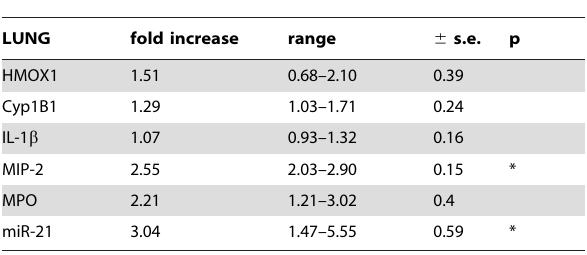
Table 3. Immunoblotting